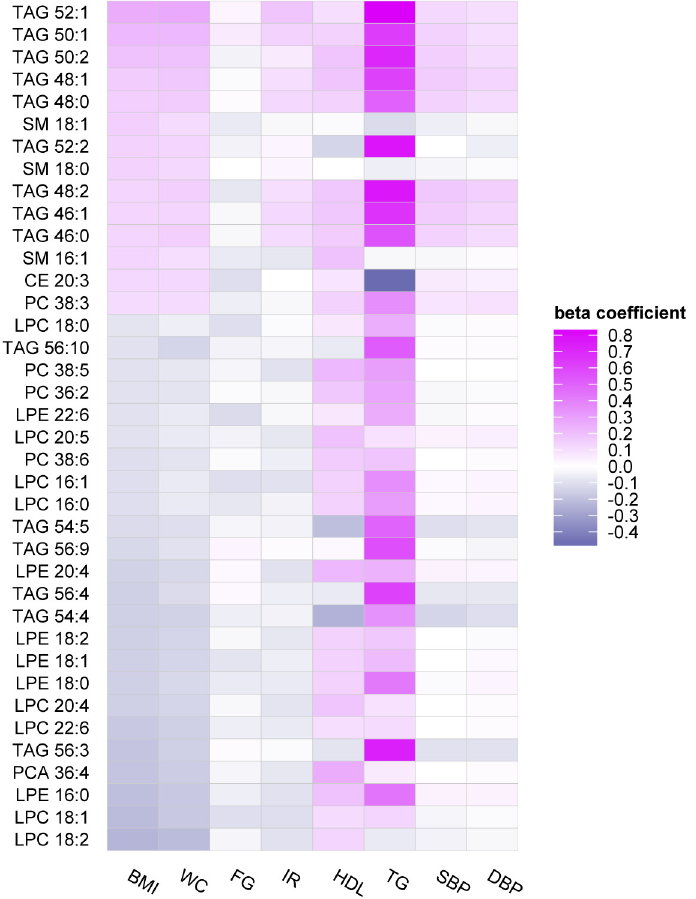
Fig 3. Heatmap of lipid metabolite profiles associated with metabolic traits.